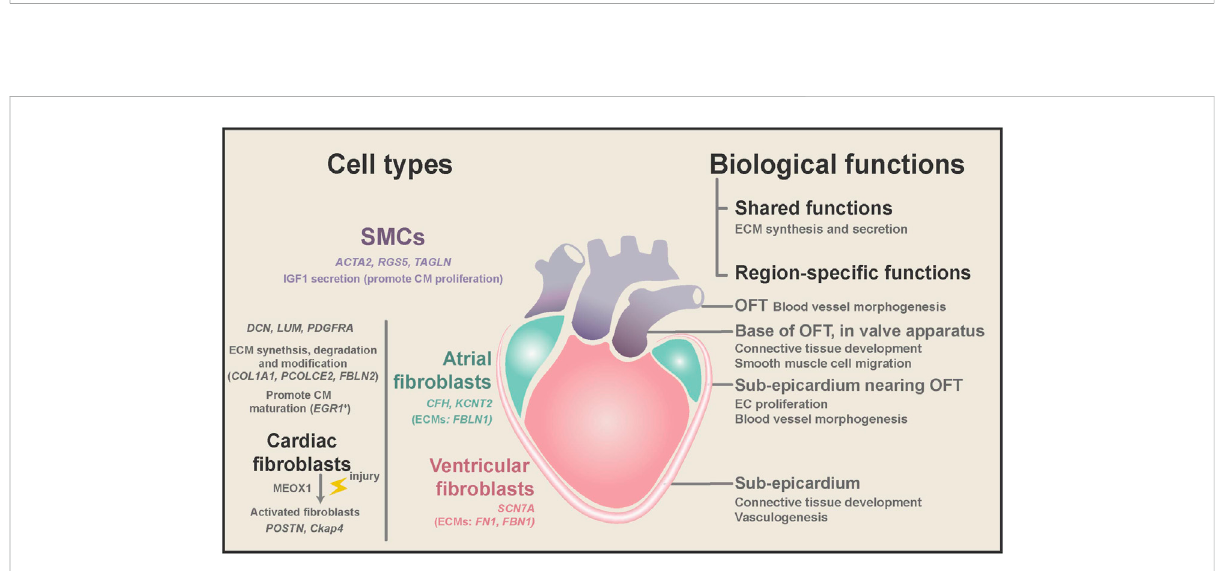
FIGURE 3 Region-speci fi ccharacteristicsof fi broblastsandSMCs,andtheirbiologicalfunctionsduringhomeostasisanddiseases.Bothcardiac fi broblasts and SMCs have ECM synthesis and secretion ability, while fi broblasts are mainly located in the heart free-wall and SMCs from the OFT. SMCs might promote embryonic CM proliferation by secreting IGF1. Cardiac fi broblasts are involved in the degradation and modi fi cation of ECM and may promote CM maturation in the embryonic heart. Cardiac fi broblasts expressed chamber-speci fi c genes and ECM genes. In diseases, cardiac fi broblasts can be activated and cause fi brosis and CM dysfunction. Spatial transcriptome analysis found that cardiac fi broblasts and SMCs have different gene ontology terms depending on their anatomical